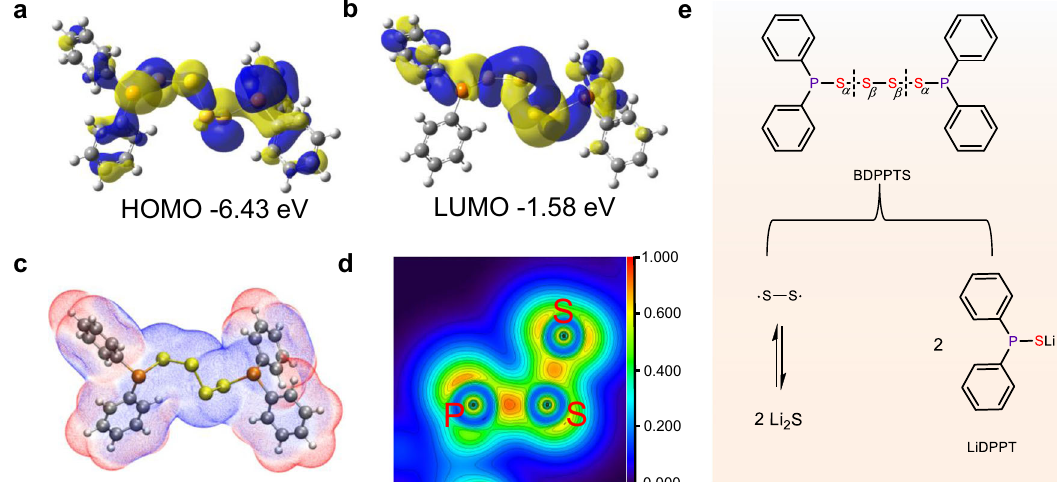
Fig. 4 Structure simulation and proposed lithiation/delithiation process of BDPPTS. a and b are the HOMO and LUMO plots of BDTTPS, respectively. c The isocontour surfaces of ESP for BDPPTS (Gray is carbon, yellow is sulfur, and orange is phosphorus). d Localized orbital locator (LOL) map of P – S and S – S bonds of BDPPTS. e Proposed electrochemical redox mechanism of BDPPTS in the Li